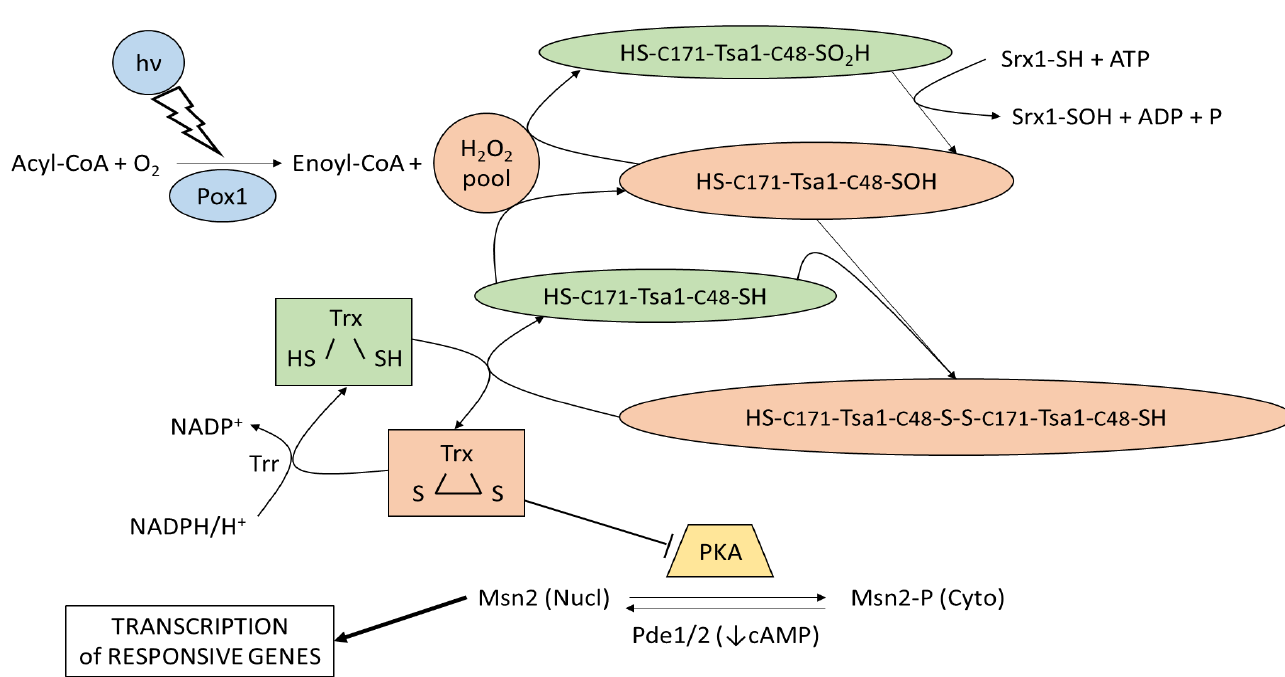
Figure 1. Light sensing and signaling in S. cerevisiae . The light-signaling cascade, from sensing up to regulation of the cellular localization of the transcription factor Msn2, modified from [30], is shown. Light (hν) is sensed by the Pox1 dependent reaction (blue) that oxidizes activated fatty acids and produces reactive hydrogen peroxide, which, in turn, triggers a cascade of sulfur-mediated oxidations (orange) involving thioredoxin peroxidase (Tsa1) and thioredoxins (Trx). Oxidized thioredoxins inhibit PKA (yellow), thus favoring the segregation of Msn2 in the nucleus and the expression of light-responsive genes. The nuclear localization of Msn2 is also favored by a low cAMP level that can be obtained by the activity of phosphodiesterases Pde1 and Pde2.